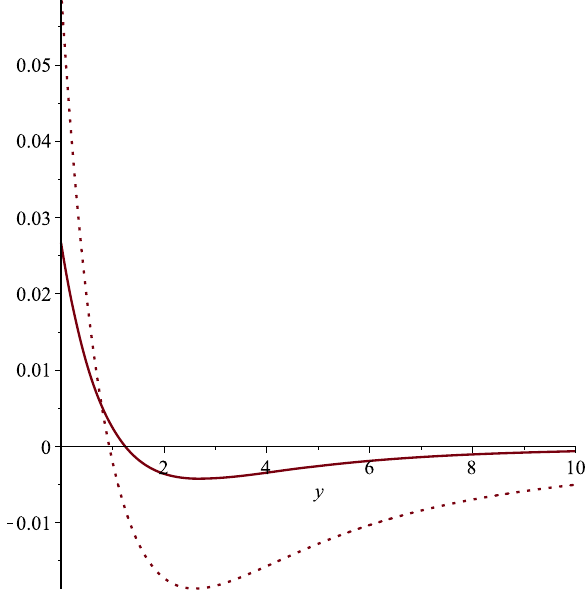
Fig. 11 Plot of the rescaled radial pressure h 2 p r /μ given by (35) with k = 100 versus y = ( r / h ) 1 /ξ in the case ξ = 1 / 2 (dotted line) and ξ = 0 . 8 (solid line). The radial pressure is positive in the inner region anditvanishesatsometypicalvalueof y whichdependsontheparticular choiceoftheEinastoparameter ξ .Outsidesuchavalueof y ,thepressure becomes negative and it exhibits a minimum. The same behaviour can be observed for all other values of ξ considered in Table